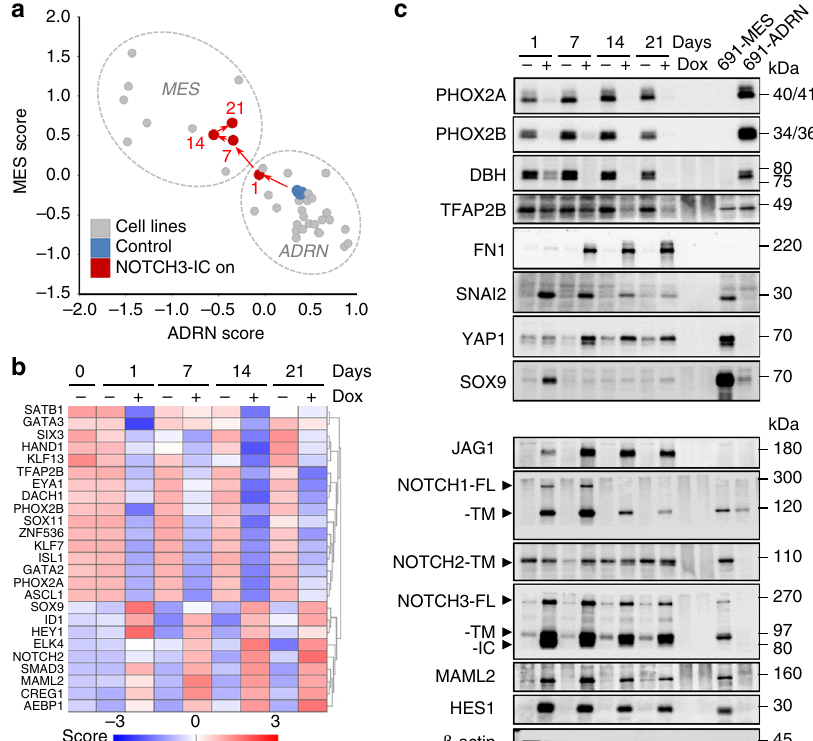
Fig. 3 NOTCH3-IC is a master regulator of ADRN-to-MES reprogramming a . Analysis of mRNA signature scores for MES and ADRN cells in a panel of neuroblastoma cell lines and a time series of NOTCH3-IC induction. Control (-dox) SH-SY5Y-NOTCH3-IC cells are depicted in blue; SH-SY5Y cells with induction of NOTCH3-IC ( + dox) are shown in red. Time of NOTCH3-IC induction is indicated in days. Dashed circles group cell lines of MES- or ADRN- type as previously determined 1 . b Z-score mRNA expression of core super-enhancer associated transcription factors speci fi c for ADRN or MES cells. Time of NOTCH3-IC induction (in days) is indicated above. dox, doxycycline. c Western blot analysis showing proteins of ADRN-markers (PHOX2A, PHOX2B, DBH, and TFAP2B), MES-markers (FN1, SNAI2, YAP1, and SOX9) and members of the NOTCH pathway (JAG1, NOTCH1, NOTCH2, NOTCH3, MAML2, and HES1) in SH-SY5Y with inducible overexpression of NOTCH3-IC. Time of NOTCH3-IC induction is indicated above the western blots. Protein lysates from 691-MES and 691-ADRN cells are loaded on the same blot as a reference for MES and ADRN states, respectively. β -actin was used as loading control. dox, doxycycline. Source data are provided as a Source Data fi